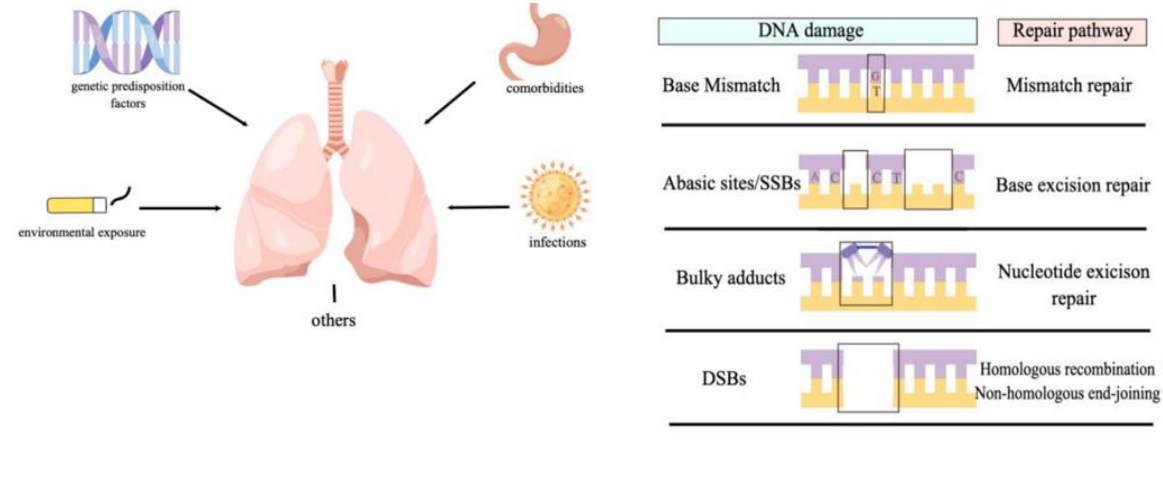
Figure 1. Risk factors of idiopathic pulmonary fibrosis and types of DNA damage and repair. ( a ) Risk factors of IPF: genetic predisposition factors, environmental exposures (wood, smoking, metal dust, etc.), comorbidities (gastroesophageal reflux disease, etc.), and infections (human herpes viruses, hepatitis C virus, etc.) ( b ) Diagram of DNA damage types and corresponding repair pathway: The mismatch repair (MMR) system maintains genome stability by repairing base mismatches during DNA replication. Abasic or AP (apurinic/apyrimidic) sites are cleaved by a DNA glycosylase in the base excision repair (BER) pathway. Nucleotide excision repair (NER) can eliminate the widest range of bulky adducts. When the DNA-double strand breaks, eukaryotic cells use two main processes to repair: homologous recombination (HR) and end-joining (EJ).